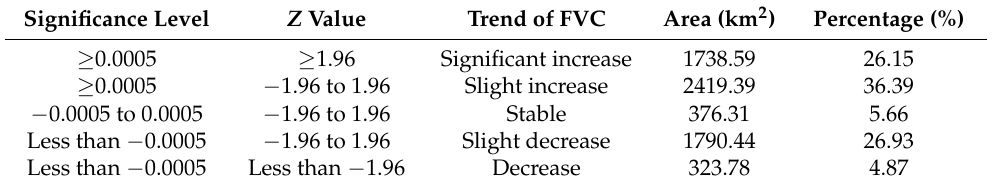
Table 1. Trend statistics of the